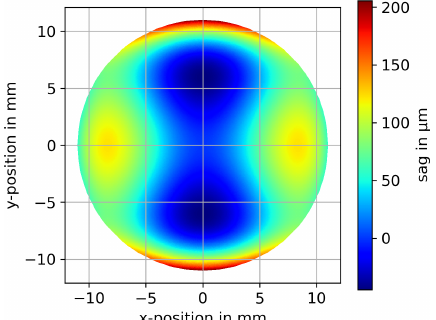
Figure 4. Expected topography of the SUT following the function shown in Eq.